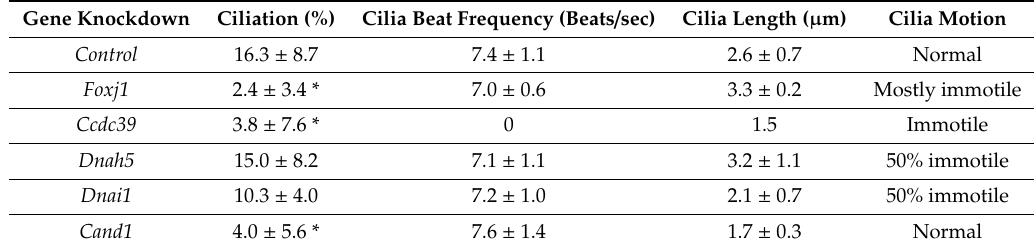
Table 1. Gene knockdown on respiratory epithelia